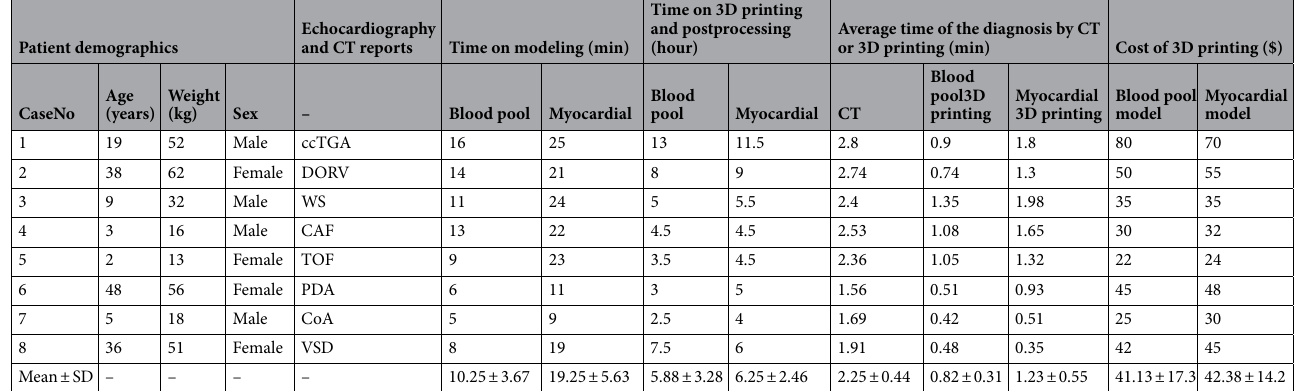
Table 1. Demographic and clinical characteristics. ccTGA congenital corrected transposition of the great arteries, DORV double outlet right ventricular, WS Williams syndrome, CAF coronary artery fistula, TOF tetralogy of Fallot, PDA patent ductus arteriosus, CoA coarctation of the aorta, VSD ventricular septal